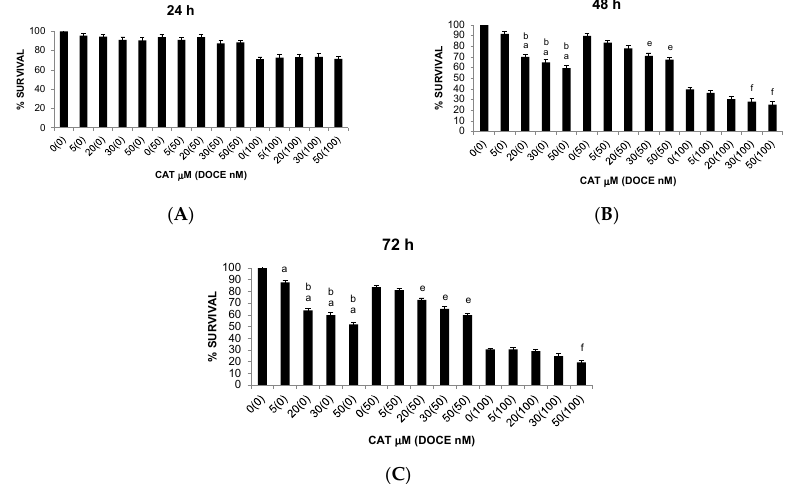
Figure 6. Trypan blue dye exclusion assay results showing viability of MDA-MB-231 cells under different concentrations of the test compound (CAT, DOCE, CAT + DOCE) at 24 h ( A ), 48 h ( B ) and 72 h ( C ). Columns, mean; bars, SE (n = 3). a represents the significant difference between CAT treatment alone and control treatment; b represents the significant difference between CAT treatment alone for 48 or 72 h and CAT treatment alone for 24 h; e represents the significant difference between combination treatment (ProB2 + DOCE 50 nM) and DOCE 50 nM alone; f represents the significant difference between combination treatment (ProB2 + DOCE 100 nM) and DOCE 100 nM alone ( p < 0.05; one-way ANOVA). Abbreviations: CAT, catechin; DOCE,